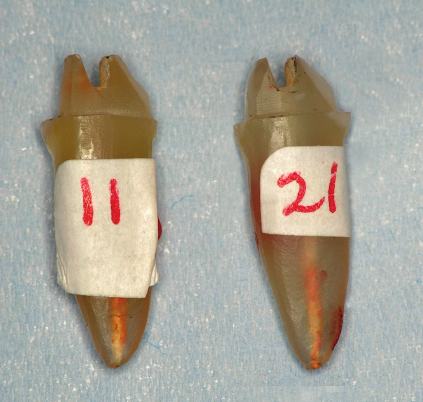
Figure 3: Specimen of each group showing the prepared contra bevel in group 2.